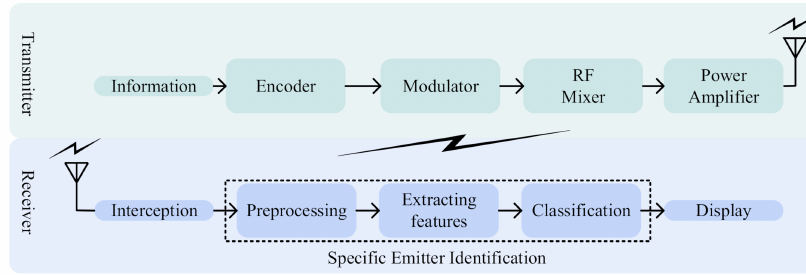
Figure 1. Workflow of